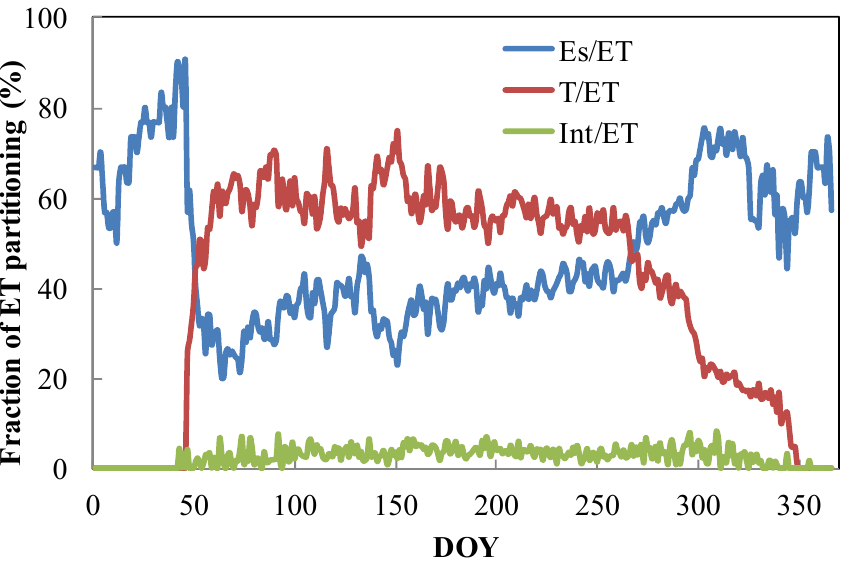
Figure 6. Fraction of ET partitioning in rainfed maize farmland during the year.